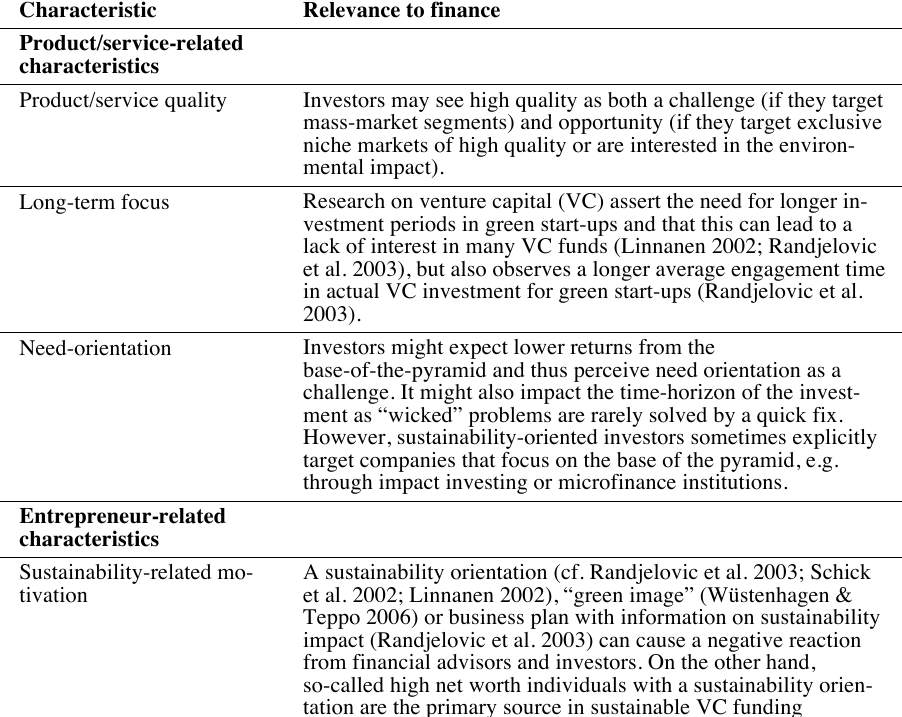
Table 2. Overview of characteristics and potential impact on financial